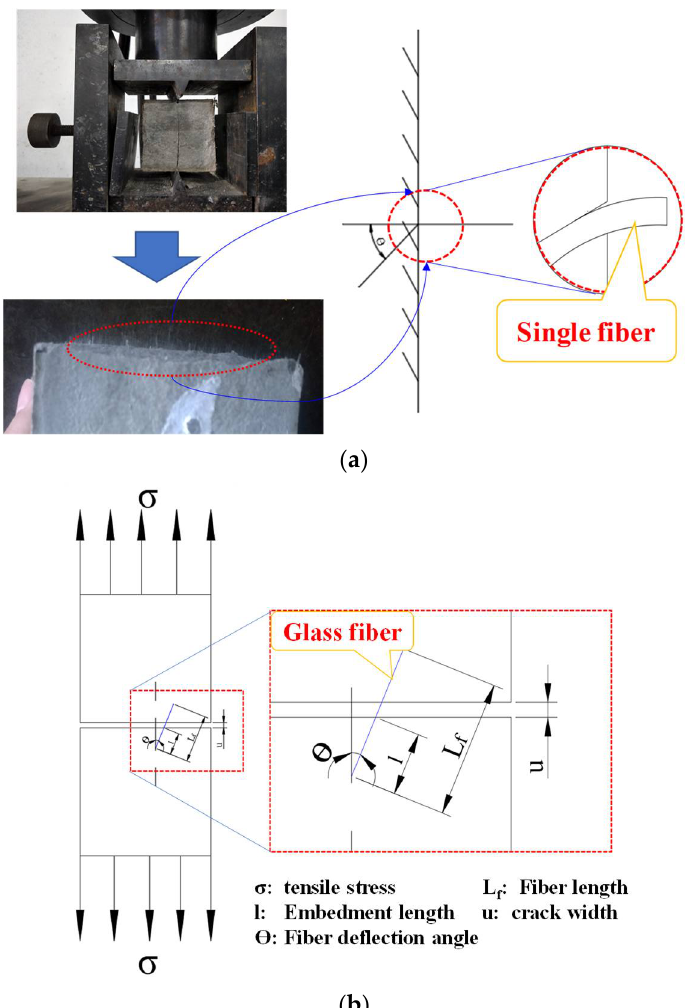
Figure 18. Microscopic features of fibers distributed in the shotcrete specimen. ( a ) Stress–strain state of a single fiber. ( b ) Mechanical performance parameters, σ: tensile stress; L f : Fiber length; l: Embedment length; u: crack width.